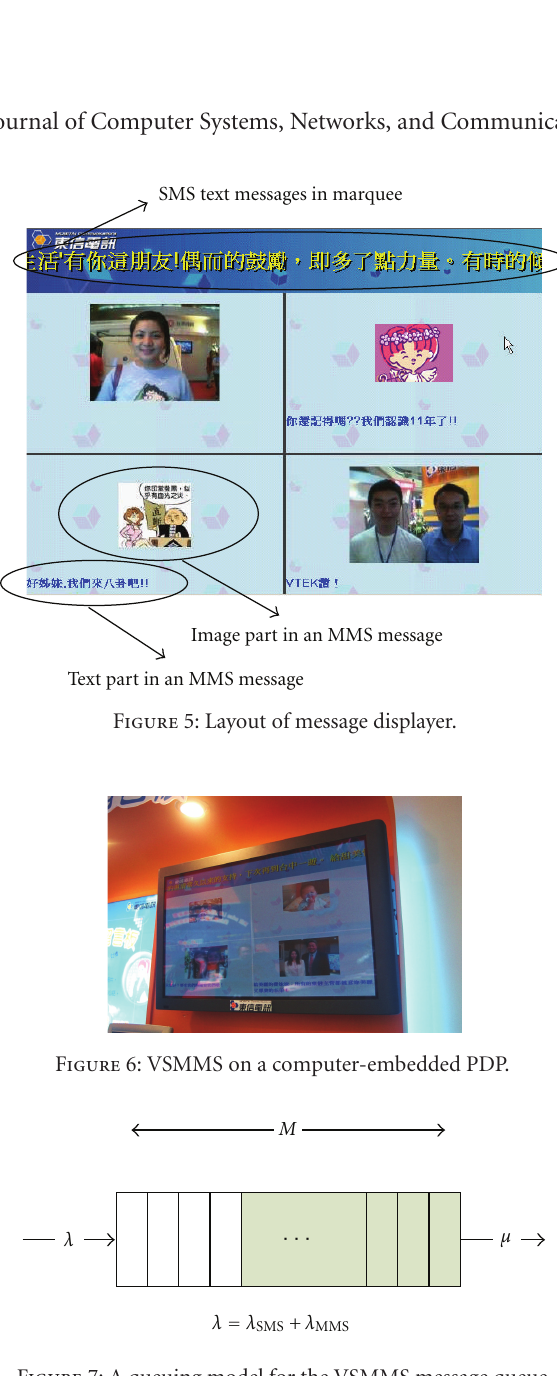
Figure 7: A queuing model for the VSMMS message queue.